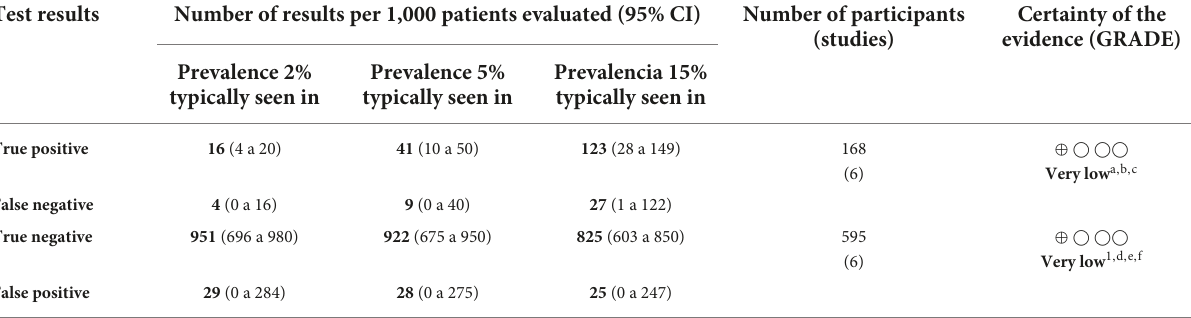
TABLE 2 Summary of the main